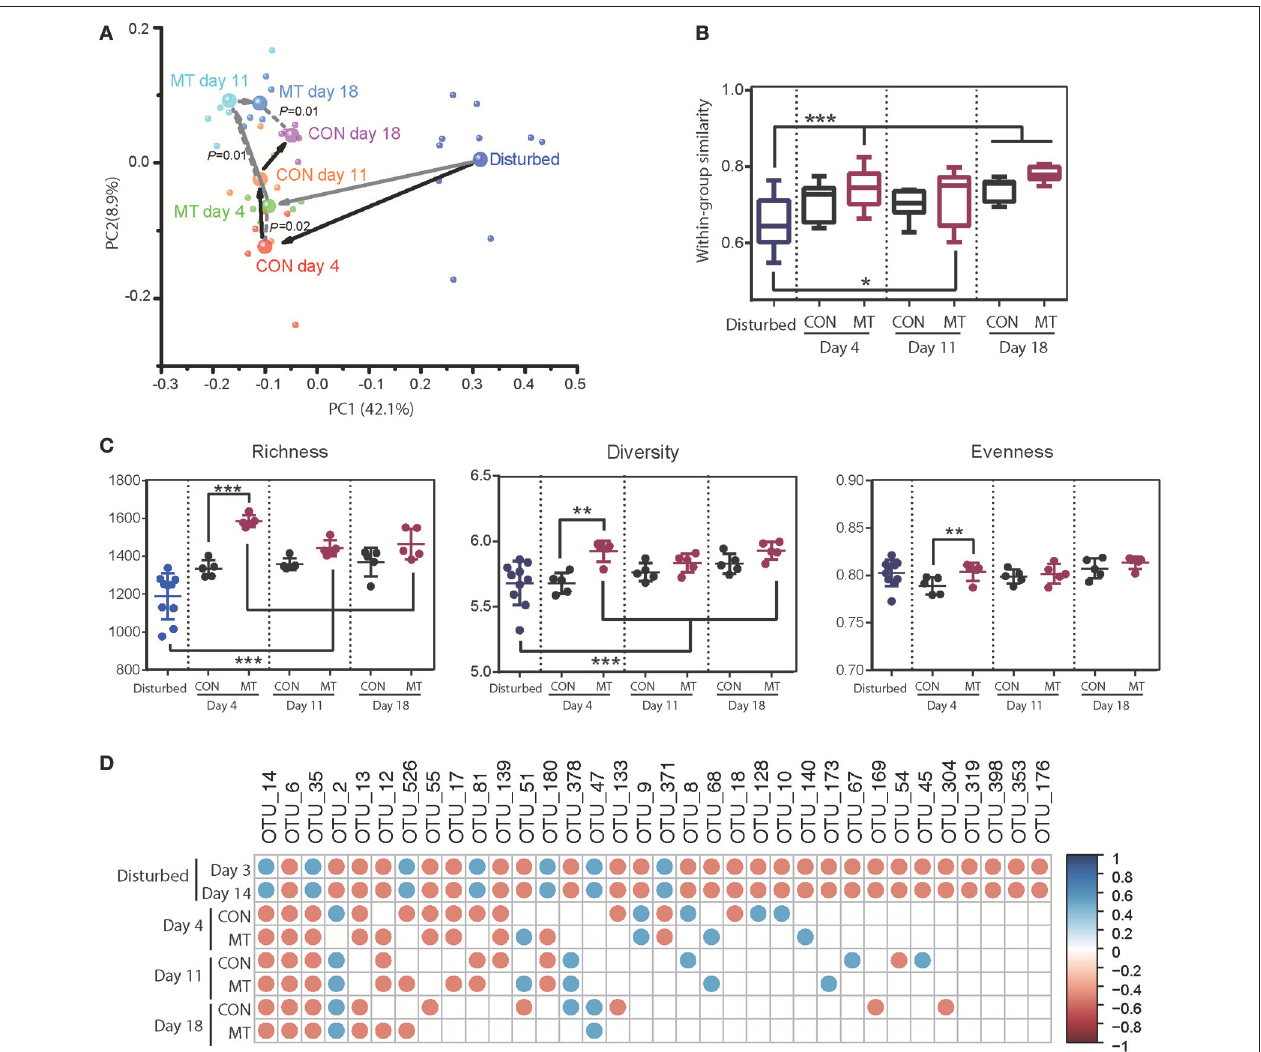
FIGURE 5 | Restoration of foregut microbiota with or without microbiota transplantation. (A) Microbiota transplantation altered foregut microbiota community. Each small bubble represents one individual cow microbiota and big one represents the representative microbiota in each group. Arrows in dark represent the change in microbiota of CON group and those in gray represent the change in microbiota of MT group cows in the first two dimensions of PCoA. Microbiota from CON and MT group cows at same time point were compared with ANOSIM analysis. (B) Within-group similarities of foregut microbiota in CON and MT group changed over time. (C) Richness, diversity and evenness of foregut microbiota in CON and MT group changed over time. (D) The restoration of antibiotic disturbed high-confidence OTUs in foregut of CON and MT group over time. All OTUs were compared with those in pre-treated cows (Start group as shown in Figure 4 ); only significantly changed OTUs at both 3 and 14 days post antibiotics administration were shown; blue dots represent significant increase and red dots represent significant decrease. Data are expressed as mean ± s.d. * P < 0.1, ** P < 0.05, *** P <